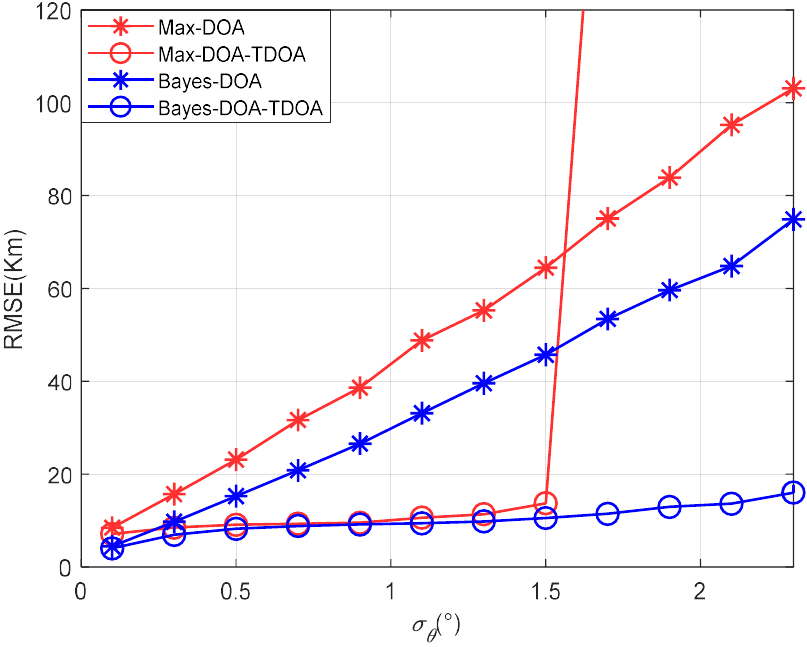
Figure 10. The positioning accuracy varies with the angle’s standard deviation.